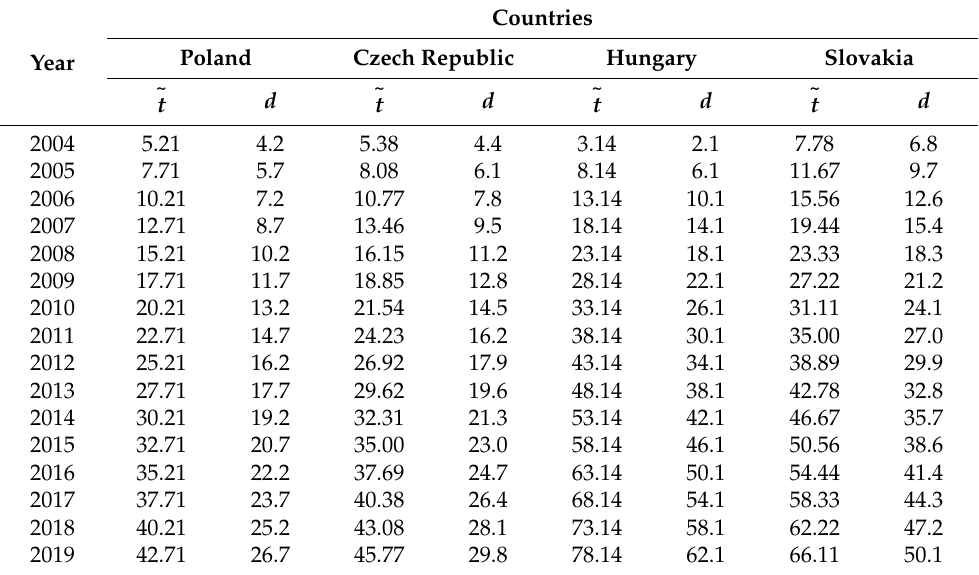
Table 7. The delay of Poland, the Czech Republic, Hungary and Slovakia in relations to Germany variant IV.